Question: Condense the content of this figure into a single sentence.
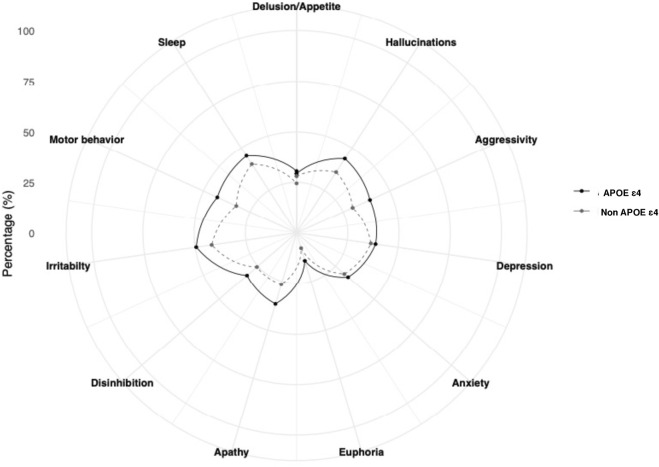
Answer: Comparison of altered neuropsychiatric items in AD patients according to APOE ε4 carriage.